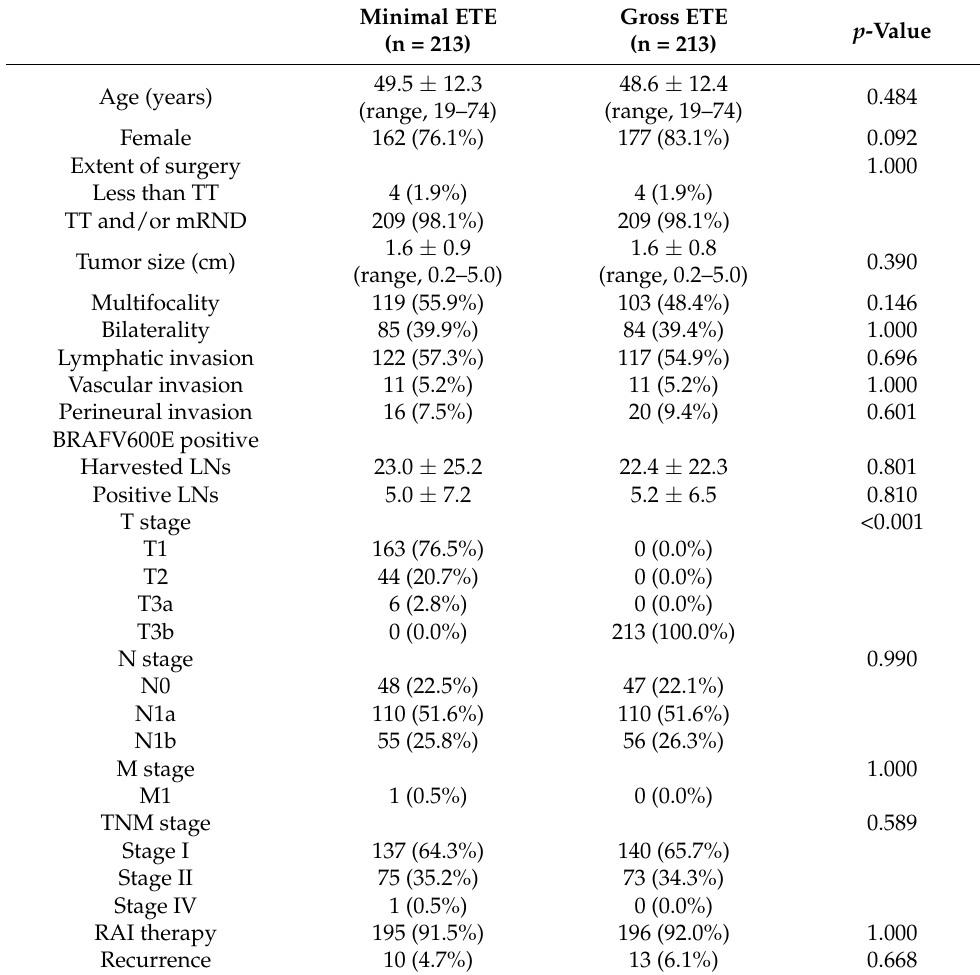
Table 3. Comparison of clinicopathological characteristics between the minimal ETE and gross ETE groups after propensity score